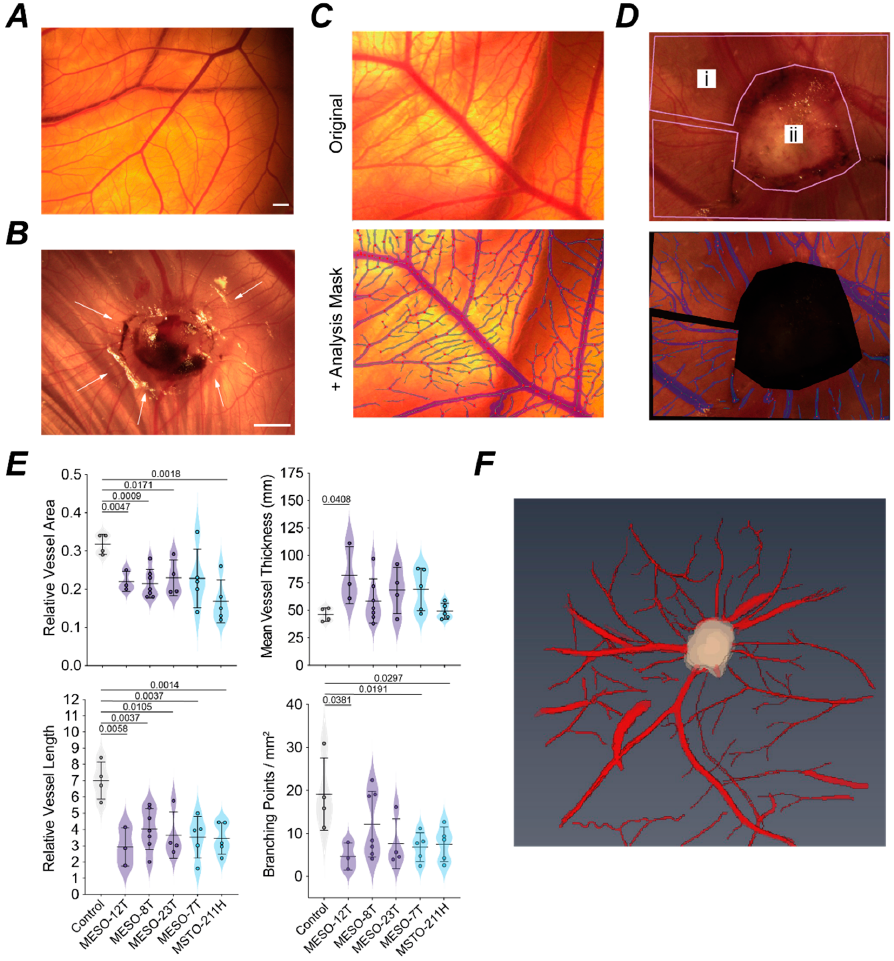
Figure 7. MPM tumour nodules remodel surrounding CAM vasculature. ( A ) Representative image of blood vessel branching on a normal non-tumour bearing CAM; scale bar 1 mm. ( B ) Radial remodelling of blood vessels (arrows) around an MPM nodule established by MESO-23T cells; scale bar 1 mm. ( C & D ) Example images of CAM vasculature for IKOSA analysis showing raw image (top) and analysis mask (below) for control non-tumour bearing CAM ( C ) and CAM vasculature around a MESO-7T nodule ( D ), (i) region used for vascular scoring, (ii) tumour nodule excluded. ( E ) Violin plots comparing characteristics of the CAM vasculature in non-tumour bearing CAM (control, n = 4) and in a 1 mm radius surrounding the tumour for MPM cell lines: MESO-12T ( n = 3), MESO-8T ( n = 7), MESO-23T ( n = 4), MESO-7T ( n = 5), MSTO-211H ( n = 5). Histological sub-types: epithelioid (purple), biphasic (blue). Total vessel area and length are expressed relative to area of analysis (mm 2 ). Normality was assessed by Shapiro–Wilk test and an unpaired t -test or Mann–Whitney test used as appropriate to compare tumour bearing CAMs to the control CAM group; p values indicate significant differences. ( F ) 3D rendered image derived from MRI analysis of the CAM vasculature around an MSTO-211H nodule. Supporting data in Figure S6B. All experiments were in ovo